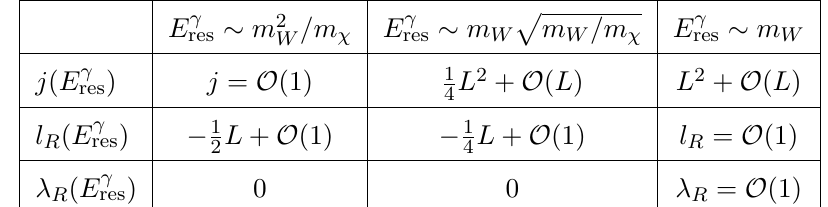
Table 1 . Leading-logarithmic dependence of the E γ order expansions when evaluated at the three E γ to be understood as power-suppressed.